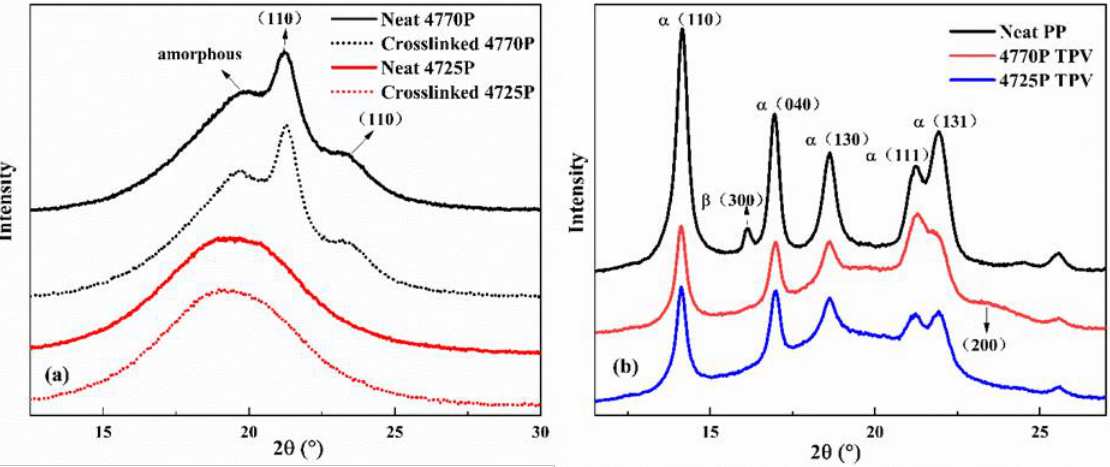
Figure 2. Wide-angle X-ray diffraction profiles for neat PP, neat EPDMs, crosslinked EPDMs, and TPVs: ( a ) EPDMs and crosslinked EPDMs; ( b ) neat PP, EPDM/PP thermoplastic vulcanizates.